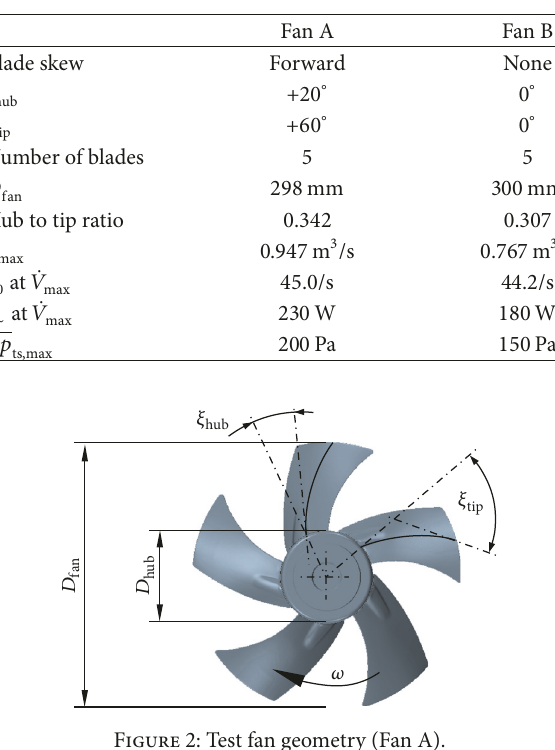
Table 1: Test fans manufacturer’s specifications.